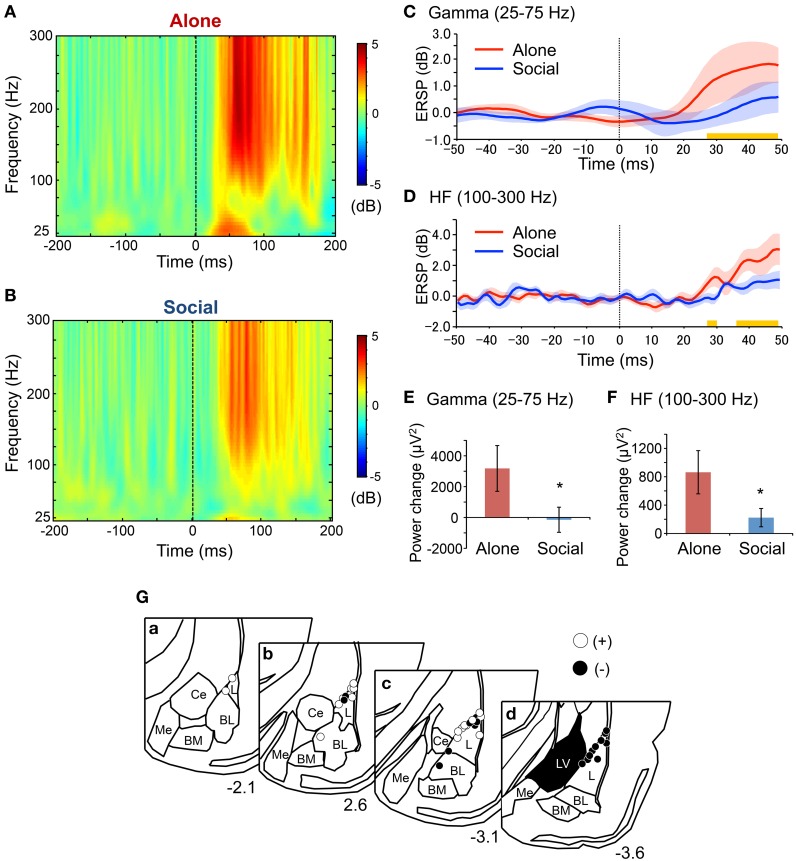
Reduction of gamma and high frequency (HF) oscillations after the CS in the Social condition in the second fear-expression test. (A,B) Averaged event-related spectral perturbations (ERSPs) in the Alone (A) and the Social (B) conditions. The dotted lines indicate CS onset. Each ERSP value was corrected for a log power spectrum of the −50–0 ms pre-tone period (in dB). (C,D) The time courses of averaged ERSP of gamma (C) and HF (D) oscillations. The red and blue solid lines indicate the mean ERSPs in the Alone and Social conditions, respectively. The corresponding translucent areas indicate the SEMs. The dotted line indicates the CS onset. Yellow bars indicate the latency windows in which there were significant differences between the conditions (P < 0.05, simple main effect analysis). (E,F) Comparison of power changes after the CS in gamma (E) and HF (F) ranges between the conditions. *P < 0.05, Wilcoxon rank-sum test. (G) Locations of the electrodes recording local oscillations in bipolar measurement. Open and filled circles indicate positive and negative poles, respectively. Other conventions are the same as those of Figure 2C.